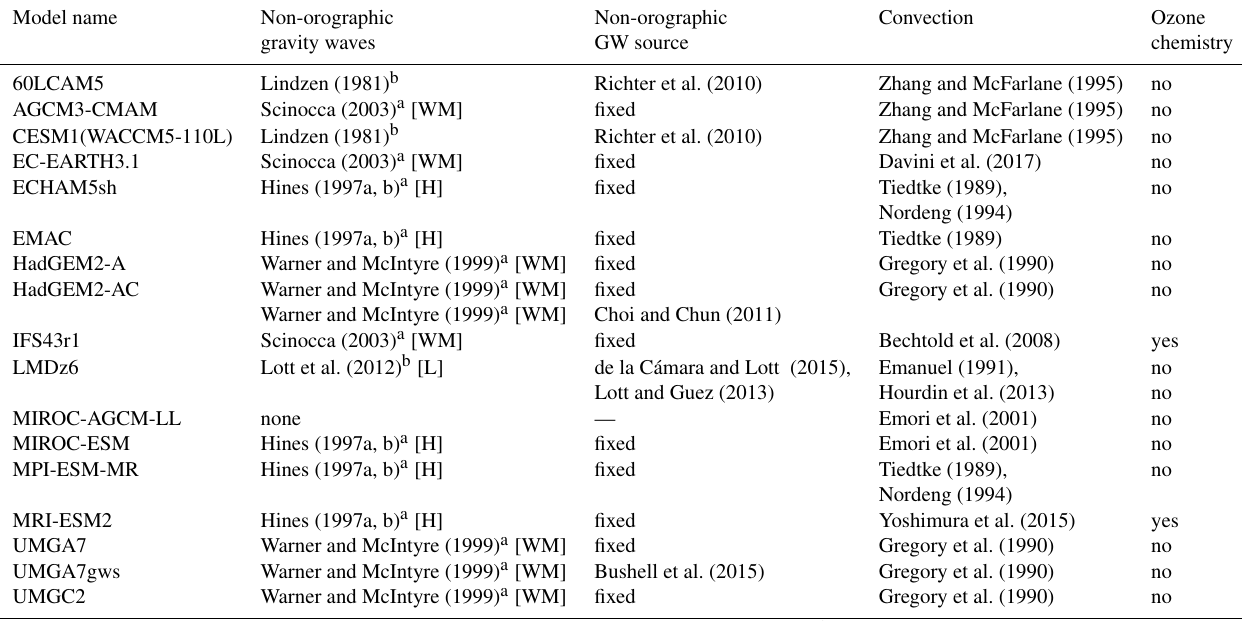
Table 8. Non-orographic gravity waves, convection, and ozone